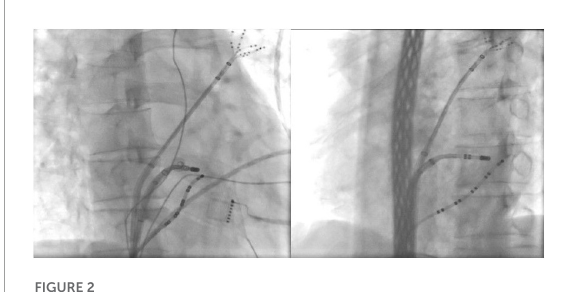
FIGURE2 Ablation target of the CSD-LA electrical connection under fluoroscopic. * (Left) right anterior oblique view; * (Right) left anterior oblique view.